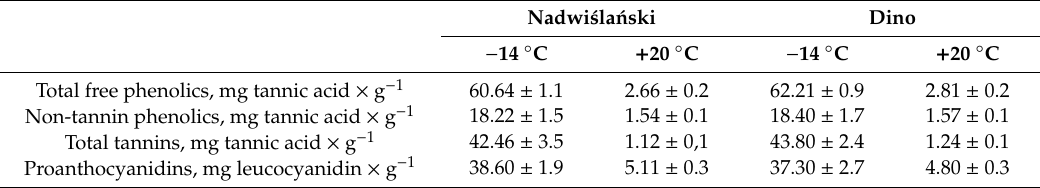
Table 2. Total free phenolic, non-tannin phenolics, total tannins, and proanthocyanidins content in field bean ( Vicia faba var. minor ) seeds stored for 30 years at − 14 °C and +20 °C.